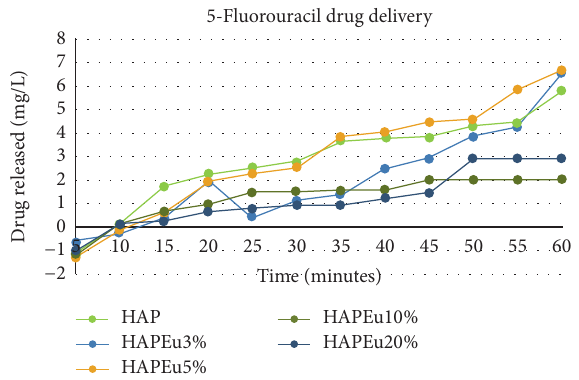
Figure 7: Drug release profile in PBS of HAP and HAPEu